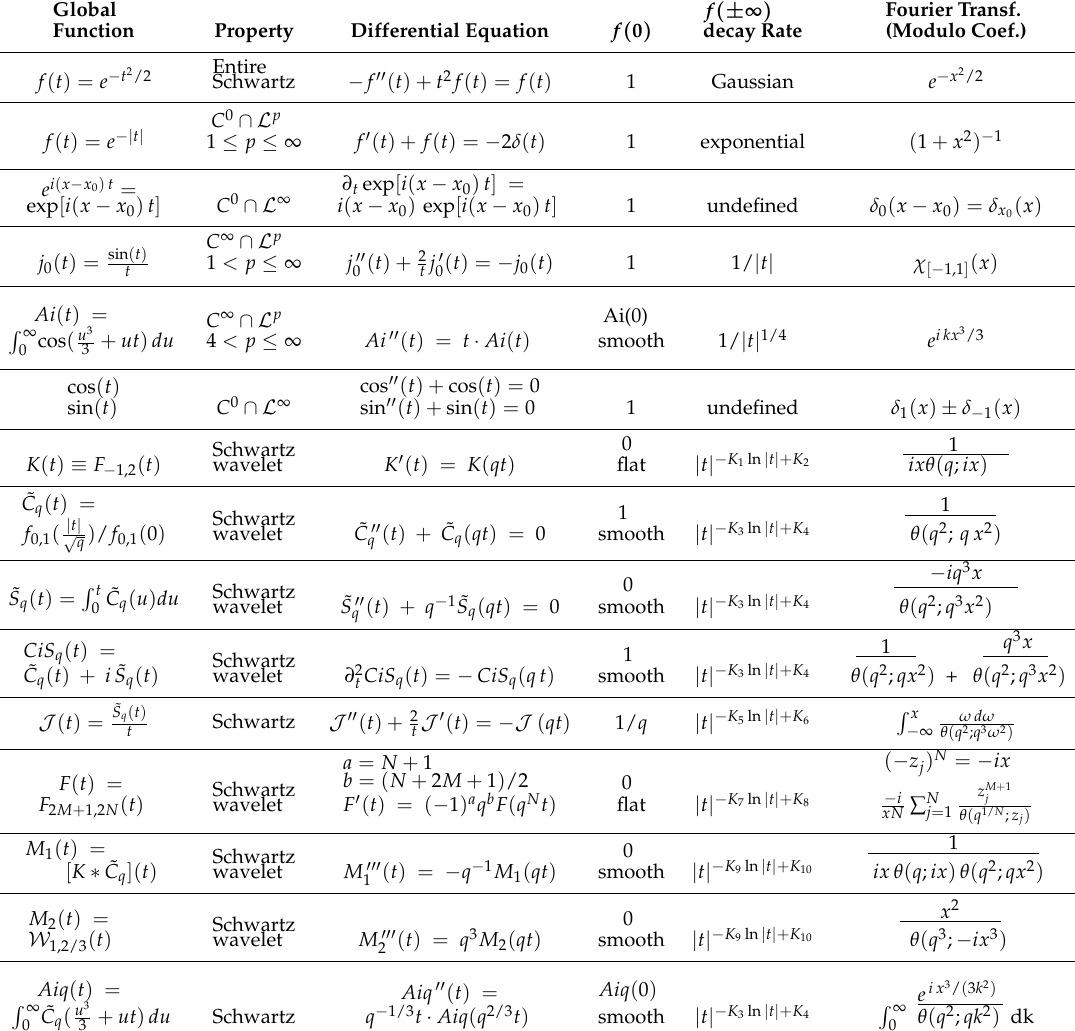
Table 1. Table of Fourier transforms with solutions of ODEs and MADEs. Global Function Property Differential Equation f ( 0 )